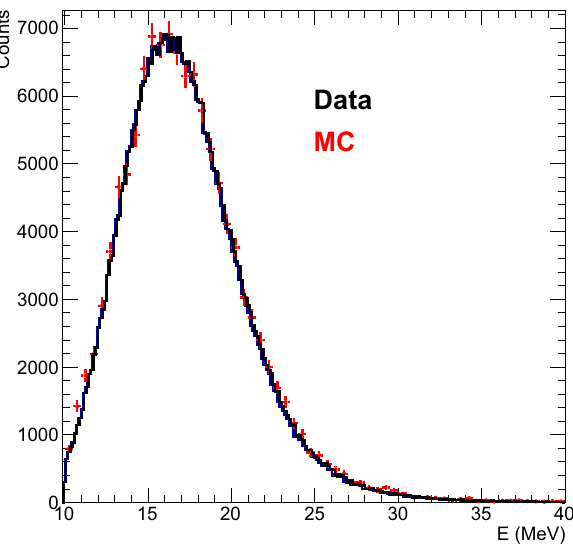
Fig. 15 A calibrated energy spectrum of a crystal of the ECal for data at 10.381GeV. Red points are for beam-related muons extracted from MC